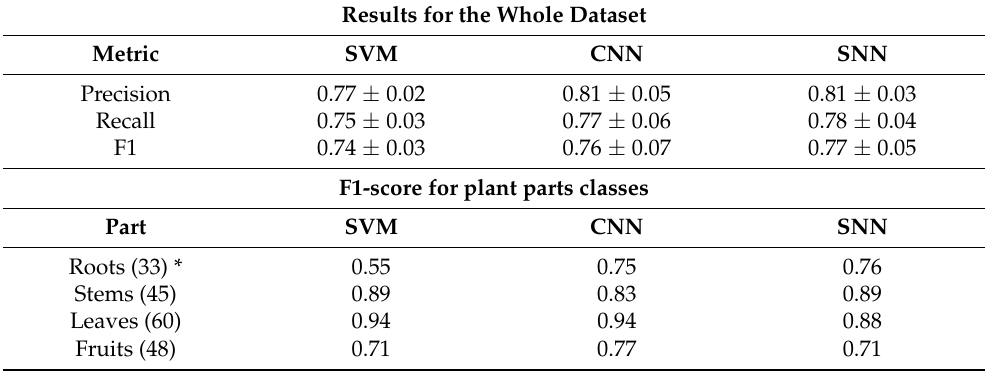
Table 5. Results of the classification by different methods. Results for the Whole Dataset